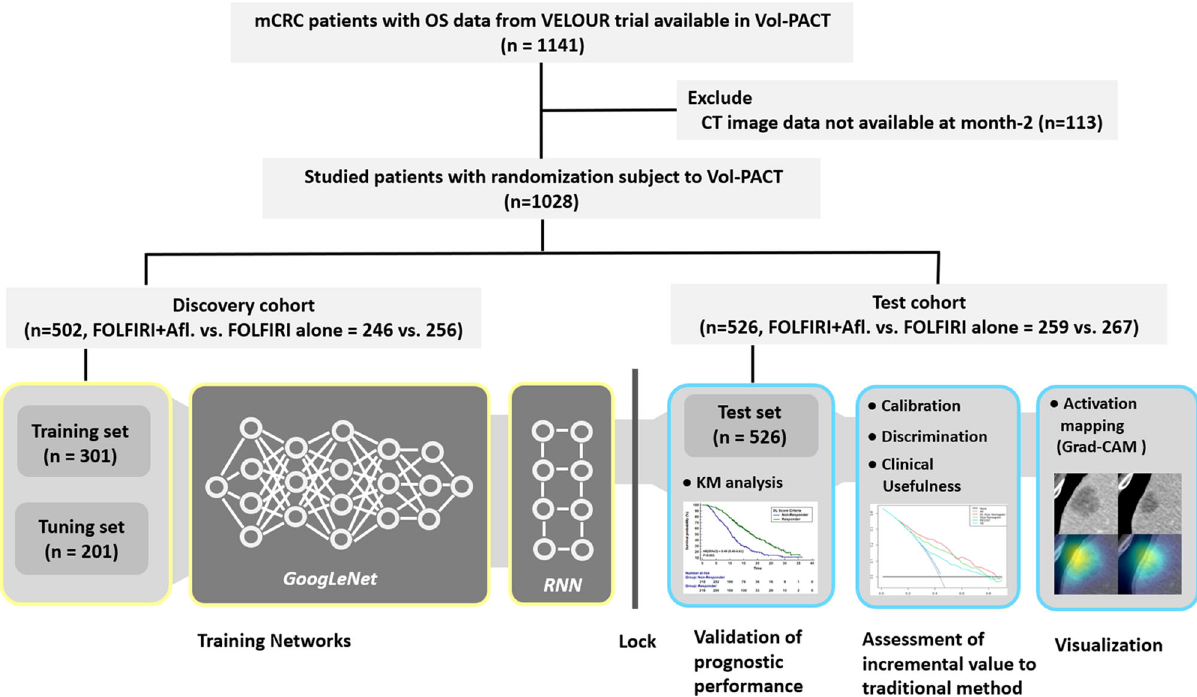
Fig. 1 Overview of study